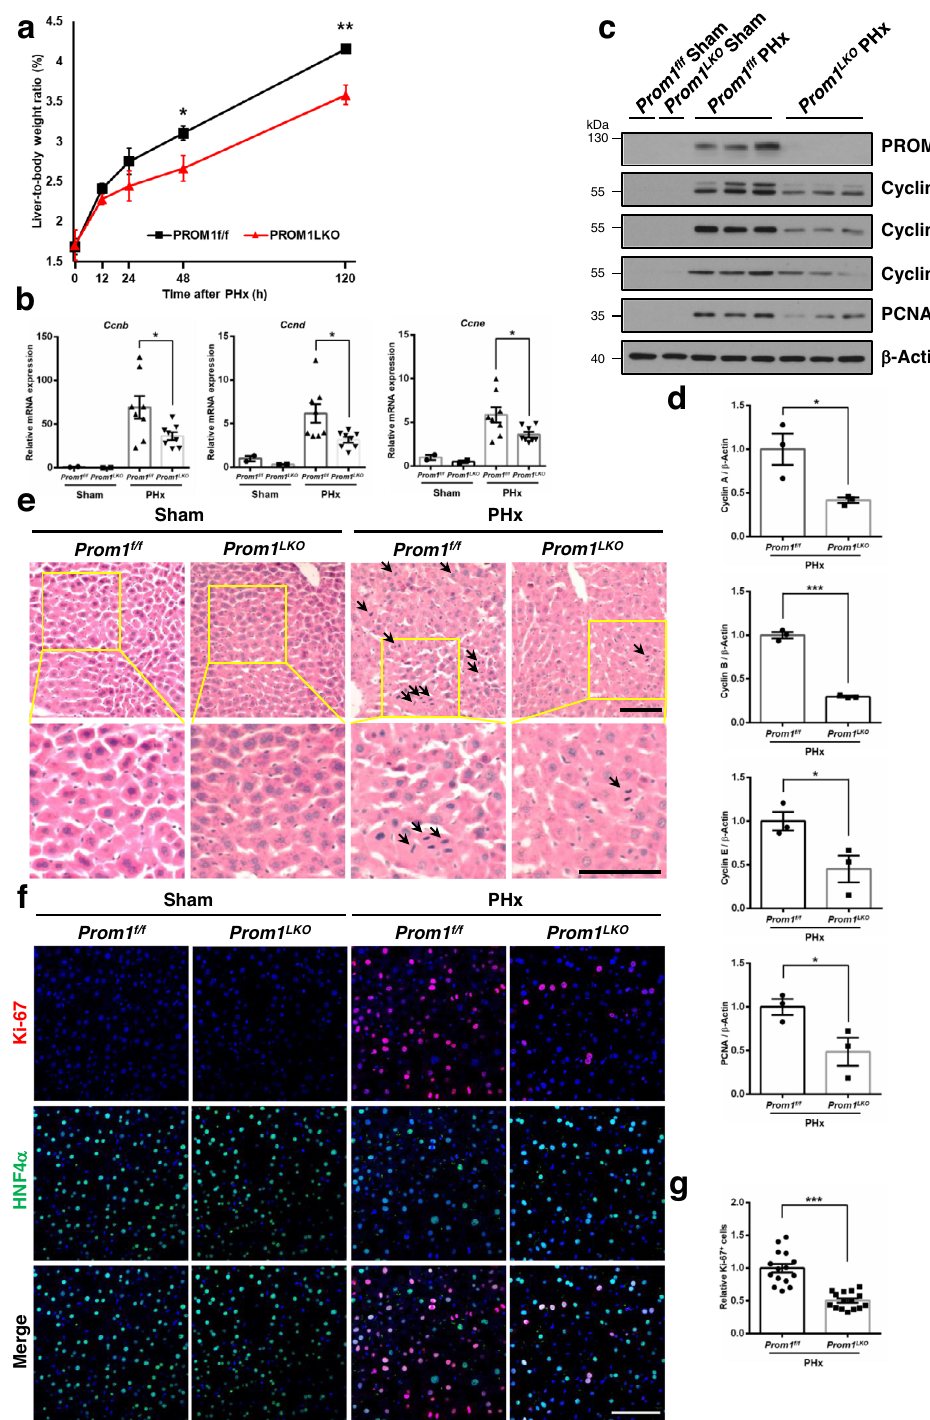
Fig.2|Liver-speci fi cdeletionofProm1inmiceimpairsliverregenerationafter partial hepatectomy. A 2/3 partial hepatectomy was performed in 8-week-old male Prom1 f/f and Prom1 LKO mice. a Ratio of liver-to-body weight on the indicated days after PHx ( n =4 for sham, 12h, and 120h, n =5 for 24h, n =7 for 48h, p =0.034 for 48h, p =0.005 for 120h). b The relative mRNA levels of cell cycle genes ( Ccnd, Ccne, Ccnb ) 48hours after PHx ( n =8). Each mRNA level was nor- malized by 18S rRNA ( p =0.041 for Ccnb , p =0.029 for Ccnd , p =0.039 for Ccne ). c ImmunoblottingforPROM1andcellcycleproteins(CyclinA,B,andE,andPCNA) 48hours after PHx. d Statistical analysis of the band intensity in c ( n =3 indepen- dent samples, p =0.032 for Cyclin A, p =4.508×10 − 5 for Cyclin B, p =0.042